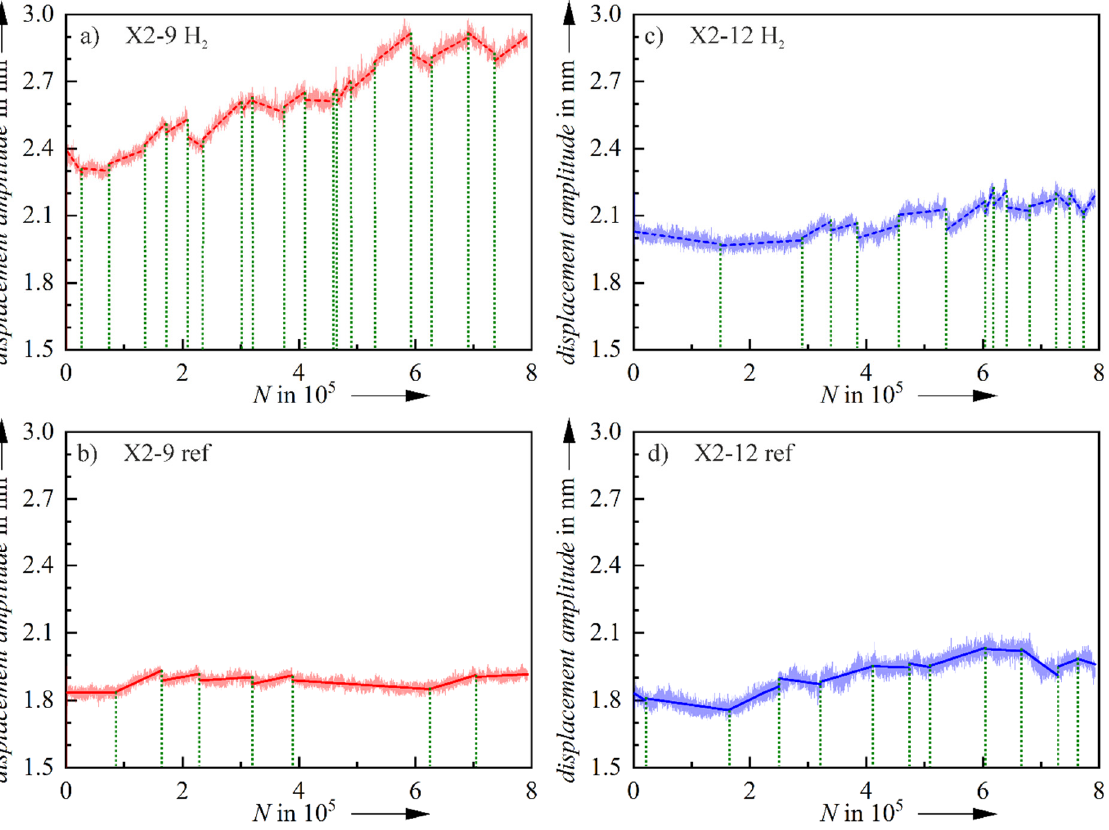
Figure 7. Examples of displacement amplitude - N curves including the definition of events for ( a ) X2-9 H 2 , ( b ) X2-9 ref, ( c ) X2-12 H 2 and ( d ) X2-12 ref.